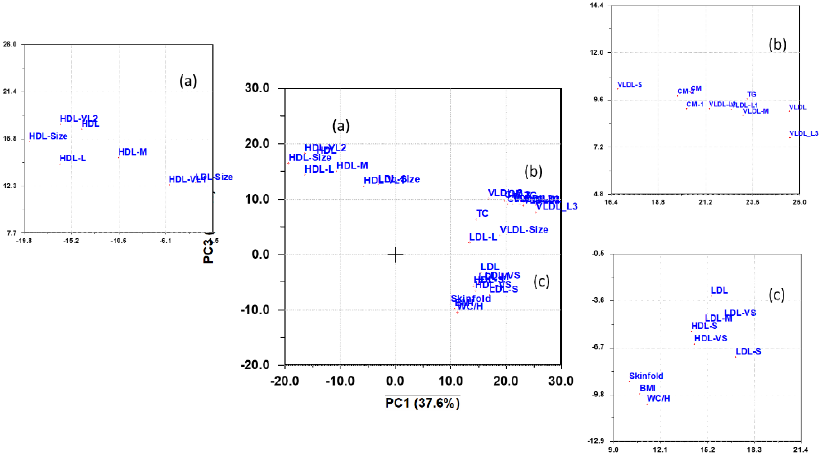
Figure 3. Loading plot displaying the partial correlations of lipoproteins and adiposity explaining 37.6 and 13.3% of the total variance in the variables on PC1 and PC3, respectively, after adjusting for age, sex, and physical activity. Groups of variables labeled ( a – c ) in the main graph are zoomed to increase resolution.